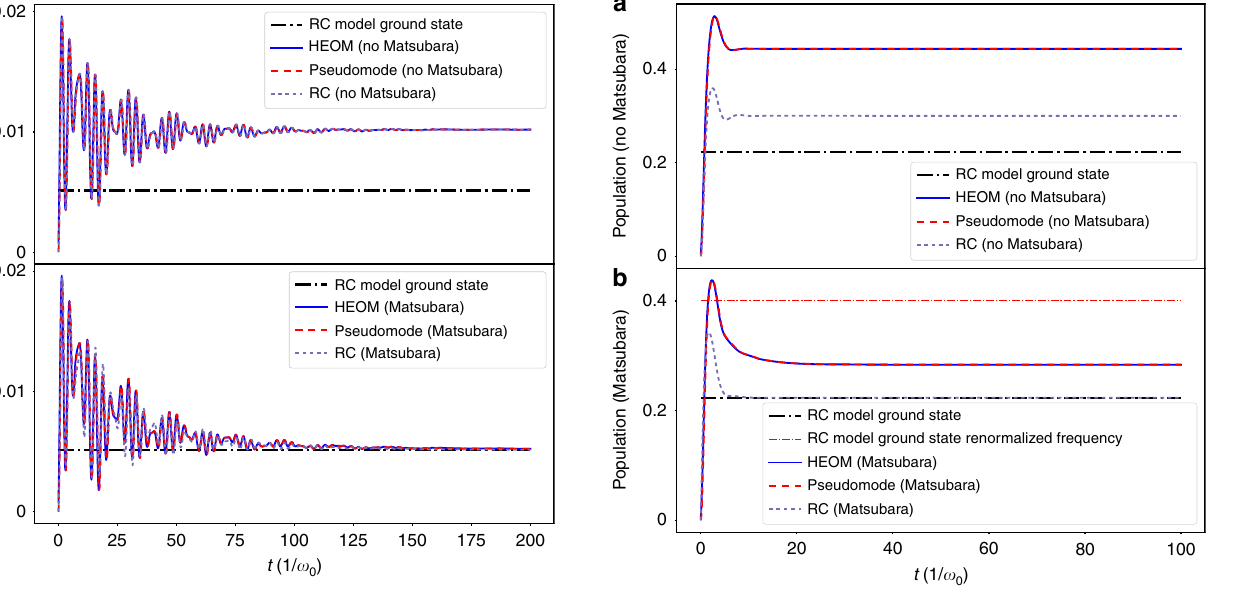
Fig. 3 Dynamics of the bath-mode occupation for intermediate coupling and Fig. 4 Dynamics of the bath-mode occupation for ultra-strong coupling and narrow bath. For the RC method, we de fi ne the bath-mode occupation in (cid:13) (cid:14) broad bath. Here, we set the parameters λ = ω 0 , γ = ω 0 , and again ω q = 0, terms of the RC mode itself a y a (light-purple dashed curves). For the Δ = ω T = 0. The upper panel ( a ) gives the results of the three models we 0 , HEOM (blue solid curves) and the pseudomode methods (red-dashed consider without Matsubara terms (both direct, and effective in the RC curves), the bath mode is the effective mode associated with the frequency case). For this choice of parameters, all the HEOM (blue solid curve) and Ω . The parameters are λ = 0.2 ω γ = 0.05 ω ω = 0, Δ = ω T = 0. The 0 , 0 , q 0 , pseudomode models (red-dashed curve) coincide, but the RC model (light- upper panel ( a ) gives the results of the three models we consider without purple dashed curve) shows some deviations because it does not take into Matsubara terms (both direct, and effective in the RC case). For this choice account the renormalized frequency Ω . In the lower panel ( b ), we show the of parameters, all three models coincide. In the lower panel ( b ), we show three models with Matsubara terms included, and now only the RC model the three models with Matsubara terms included, and all three tend tends to the ground state of H RC , while the pseudomode and HEOM models towards to a steady-state which corresponds to the ground state of H RC coincide and take into account corrections due to strong correlations with (dashed-dotted black line) the effective “ Matsubara modes ” (note that the RC model is not corrected by just including the renormalized frequency, as shown by the red dot- dashed line, which shows the ground-state occupation for an RC model with a phenomenologically altered frequency, i.e., by setting the frequency of the RC mode to be equal to Ω